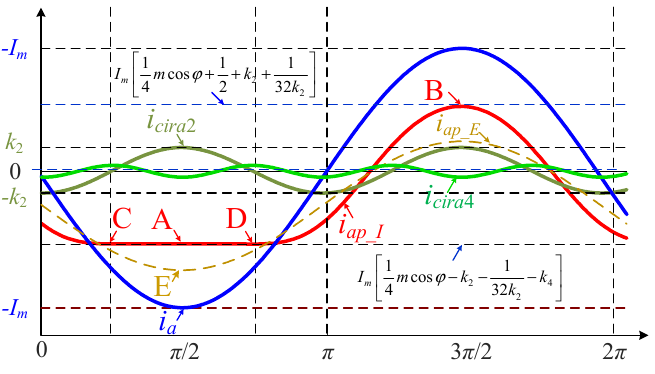
Figure 4. Schematic diagram of the arm current of the MMC with the MCCIC scheme in the rectifier